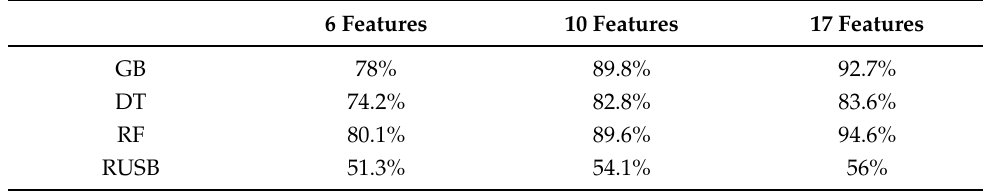
Table 13. Accuracy of the ML algorithms to predict the outcome Severity. SMOTE was used.